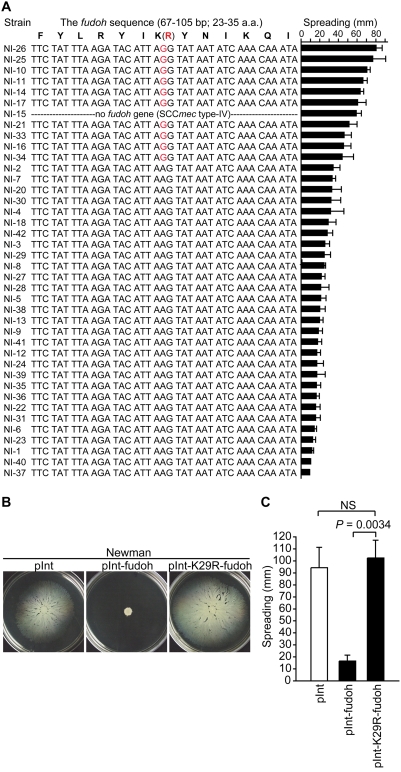
The fudoh gene is mutated in high-spreading MRSA strains.(A) The fudoh gene of 40 MRSA strains was sequenced. The sequences are organized according to the amount of colony spreading. The amounts of colony spreading are shown in the right bar graph from higher to lower values. The mutated nucleotide residues and the substituted amino acid residue are colored red. (B) The Newman strain was transformed with an integration plasmid harboring either the intact fudoh gene (pInt-fudoh) or a mutated fudoh gene (pInt-K29R-fudoh), and colony spreading was examined. The photograph was taken after 10 h incubation. (C) The means±standard deviations of the halo diameters from three independent experiments are presented.